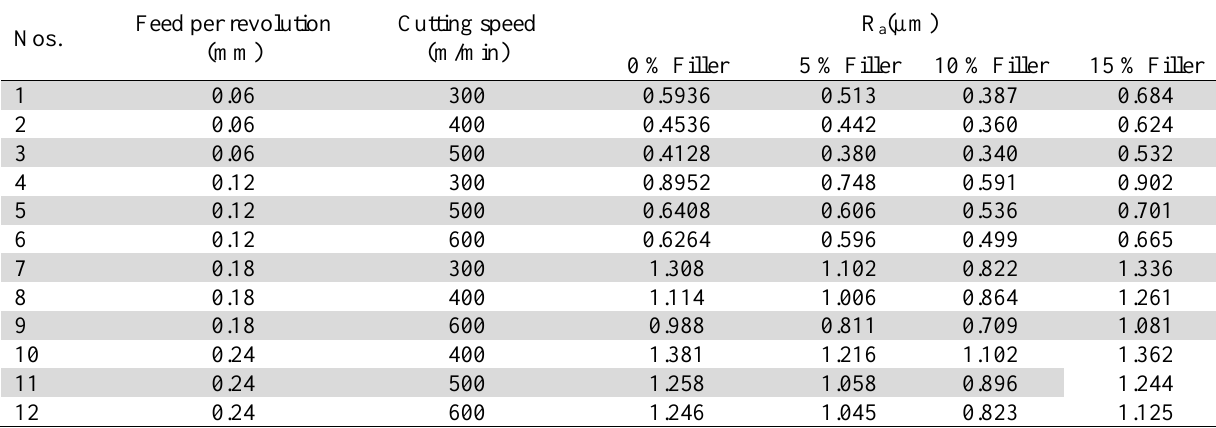
Measurement Results (Rao & Bhagyashekar, 2014)